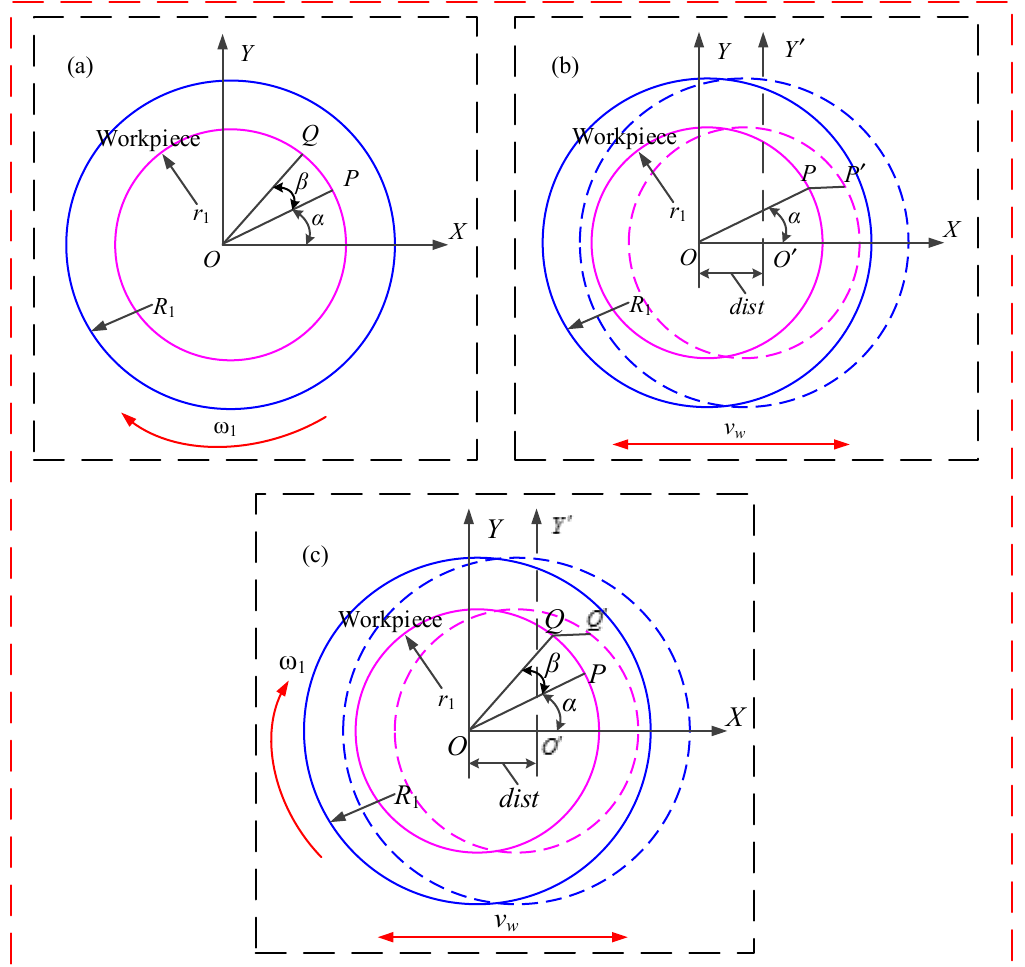
Figure 4. Kinematic diagram of the abrasive particle: ( a ) kinematic diagram of the abrasive particle during the rotation of the workpiece; ( b ) kinematic diagram of the abrasive particle during the translation of the workpiece; ( c ) kinematic diagram of the abrasive particle during the rotational and translational motion of the workpiece.